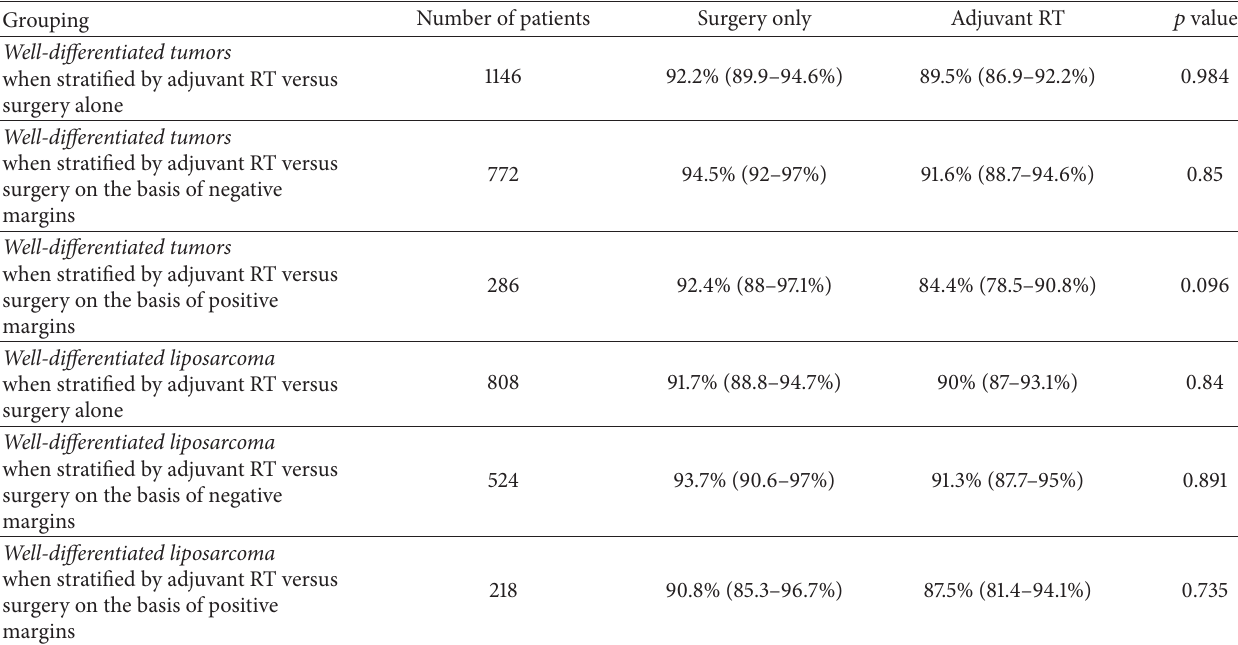
Table 3: Five year propensity matched